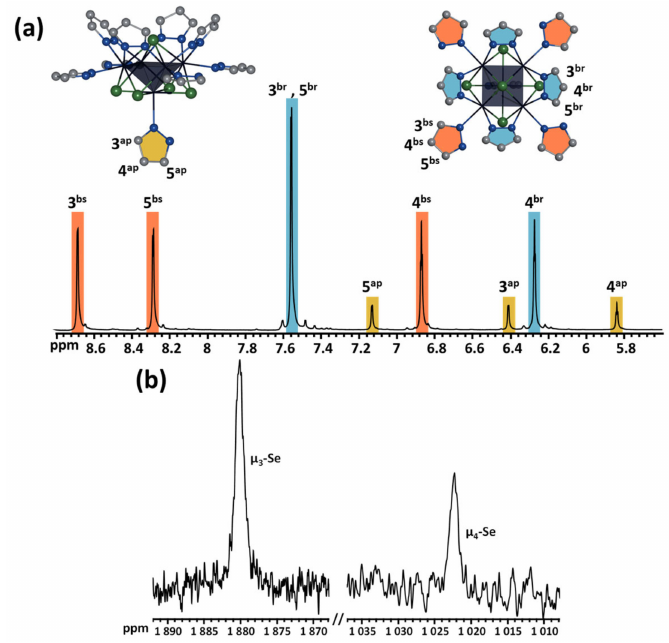
Figure 6. 1 H ( a ) and 77 Se ( b ) NMR spectra of Mo 5 ox in CD 3 OD.